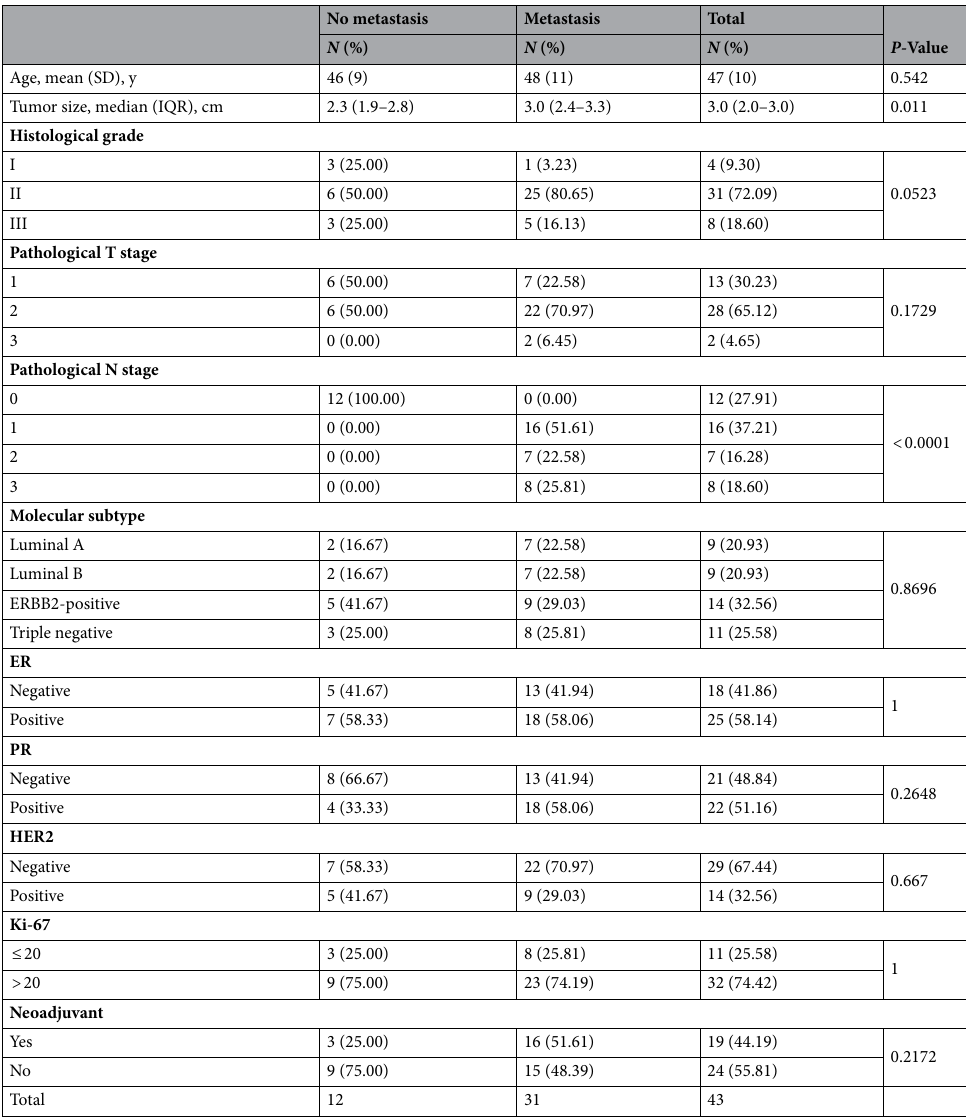
Table 1. Clinicopathological characteristics of patients in the entire